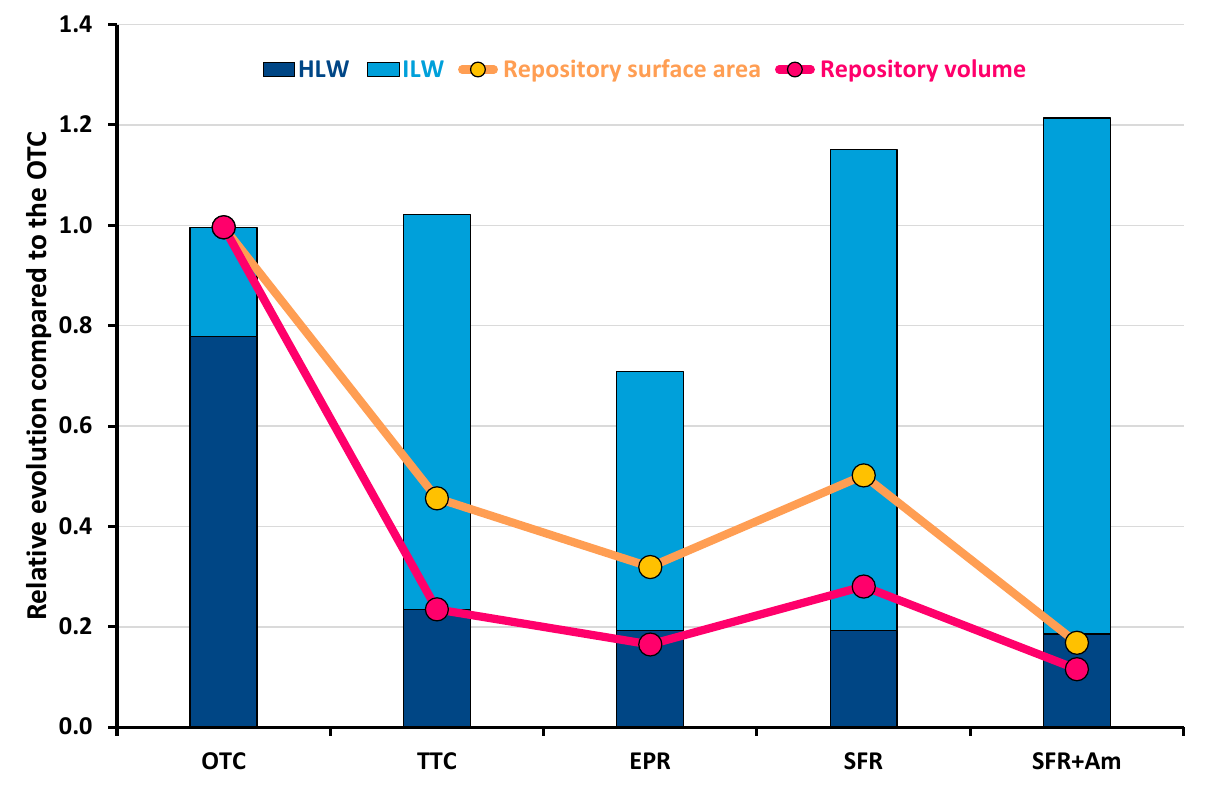
Figure 11. Variation in HLW and long-lived ILW waste volumes and repository size for different French fuel cycle scenarios. Redrawn from data in [49].